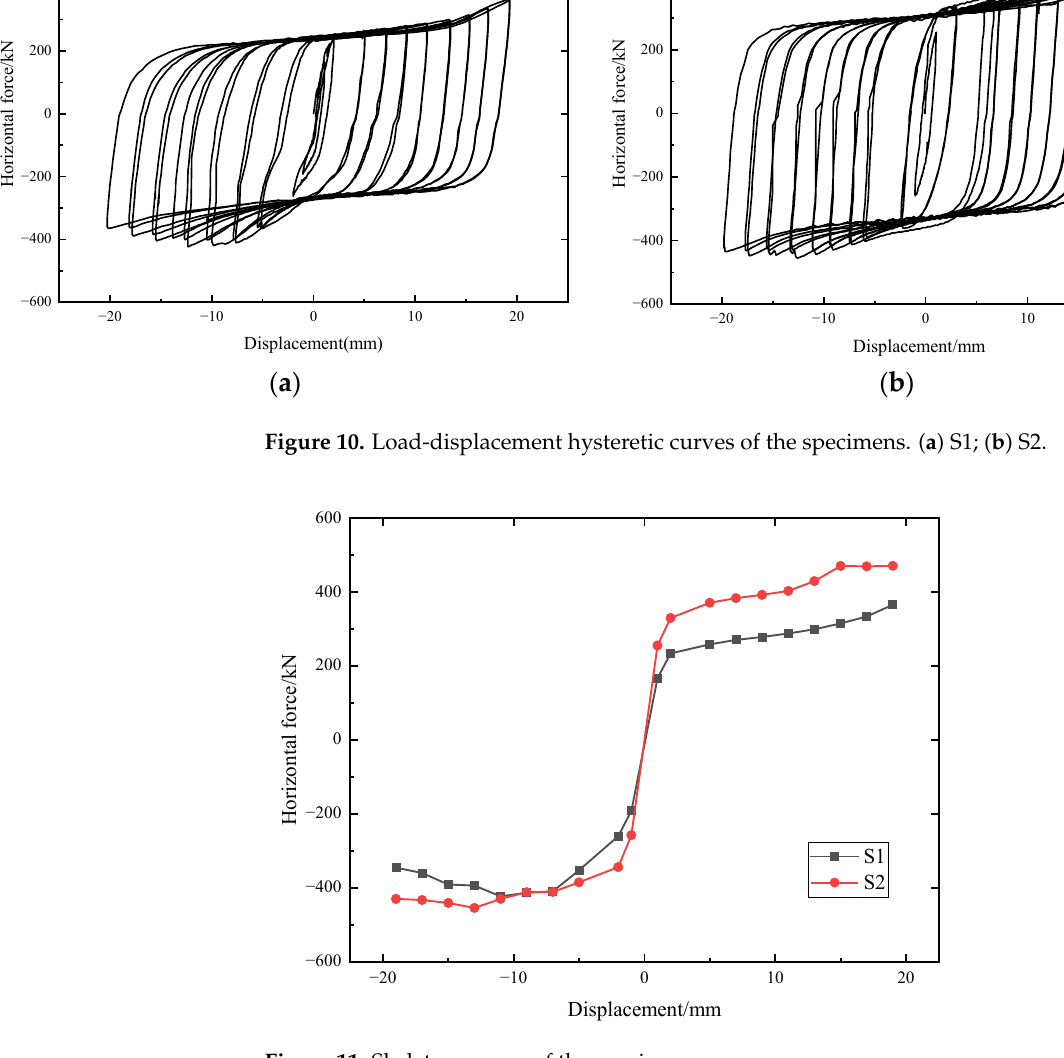
Figure 11. Skeleton curves of the